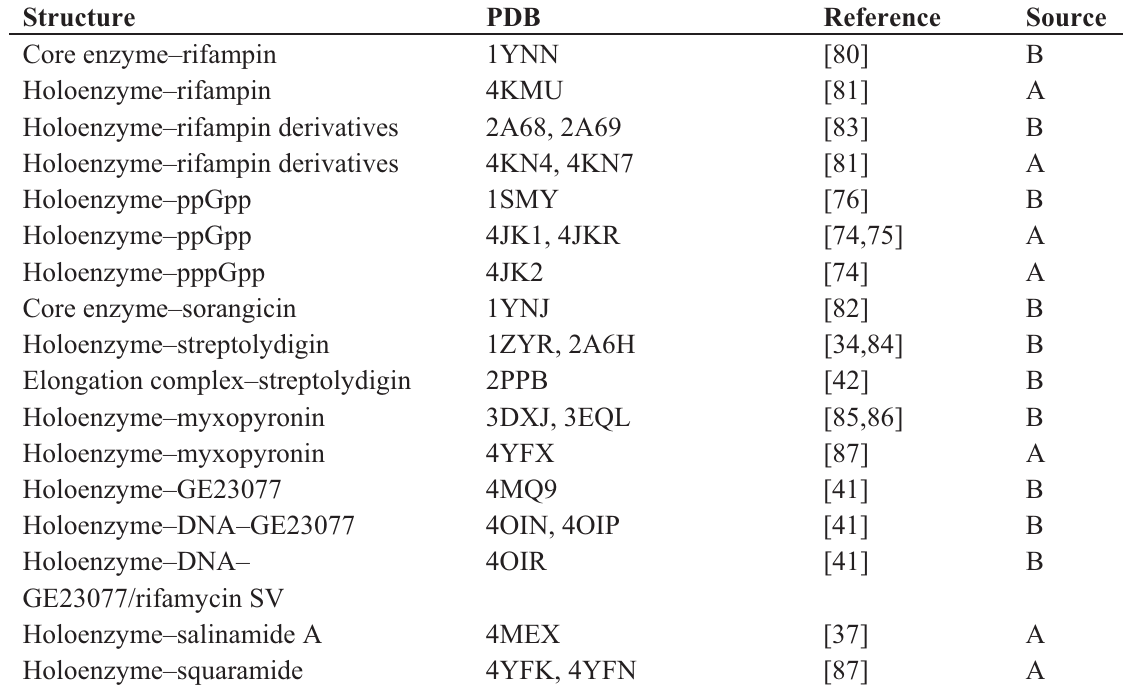
Table 3. Structural information on bacterial RNAP and small molecule inhibitor complexes *.